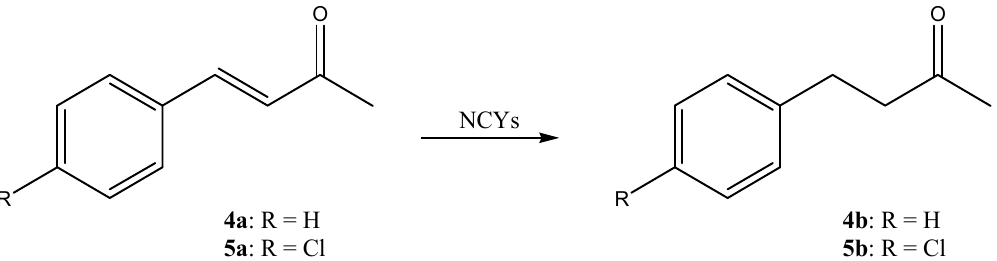
Figure 3. Reaction scheme of the bioreduction of substrates 4a and 5a to products 4b and 5b , respectively, by NCYs.